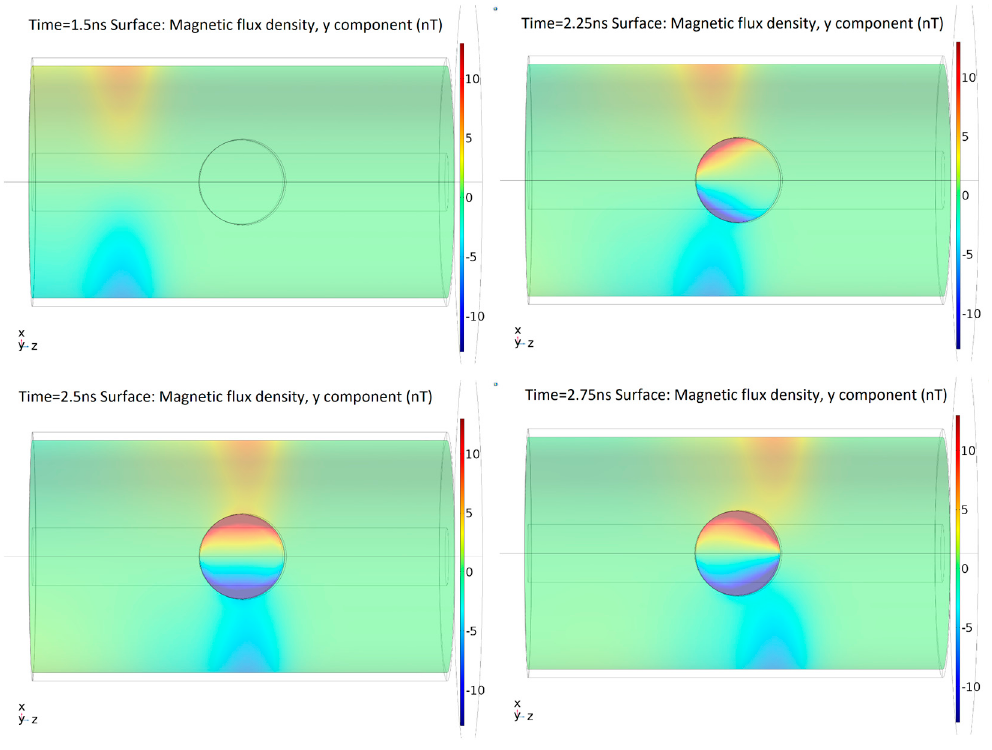
Figure 6. Magnetic flux density perpendicular to the dielectric window at different times.